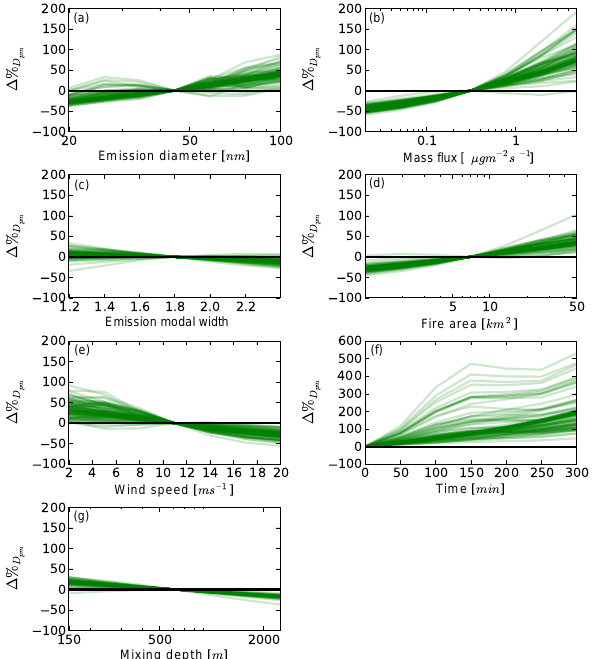
Figure 7. Sensitivity plots for the seven input parameters to the GEM-SA D pm parameterization. For each panel, a single input pa- rameter is varied systematically from its minimum to maximum value for 100 randomly chosen sets of the other six parameters (100 lines in each panel). The sensitivities are shown as percent change in final D pm , individually normalized to the value at the center of the x axis (to zero in time).